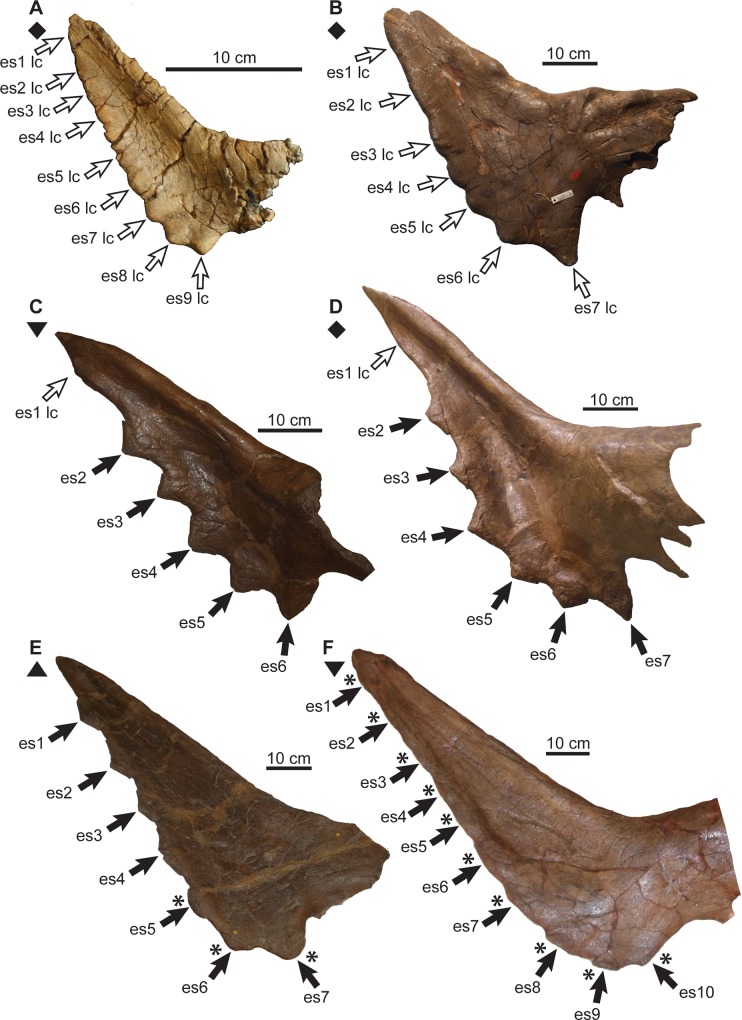
Ontogenetic changes in squamosal of Chasmosaurus.Increase in length/width ratio (character 12), changing outline of lateral margin (character 13), articulation (character 14) and remodeling (character 15) of episquamosals: (A) TMP 1998.128.0001 (flipped), (B) CMN 1254, (C) AMNH 5656, (D) AMNH 5401, (E) NHMUK R4948 (courtesy of J. Mallon), and (F) CMN 8800. Blank arrows = unadorned episquamosal loci; solid arrows = articulated episquamosals; solid arrows with asterisks = remodeled episquamosals. Chasmosaurus belli (triangle), Chasmosaurus russelli (inverted triangles) and Chasmosaurus sp. (diamonds). [planned for page width].